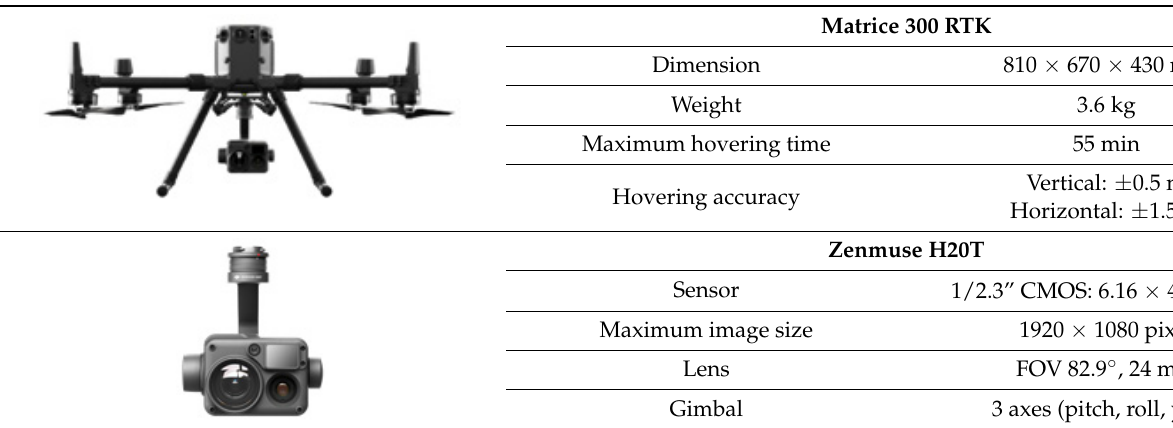
Table 1. Drone and camera used in the study.